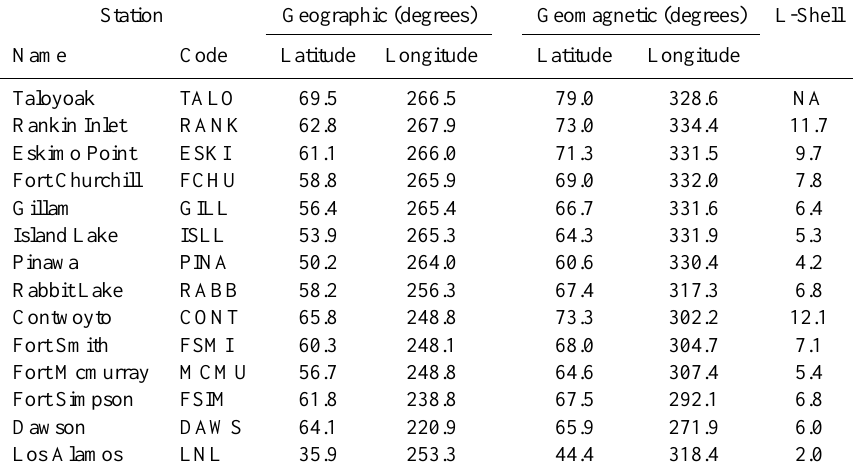
Table 1. Coordinates and L-shell values for the CARISMA and LNL magnetometers. All values were calculated using the International Geomagnetic reference Field for 1998.